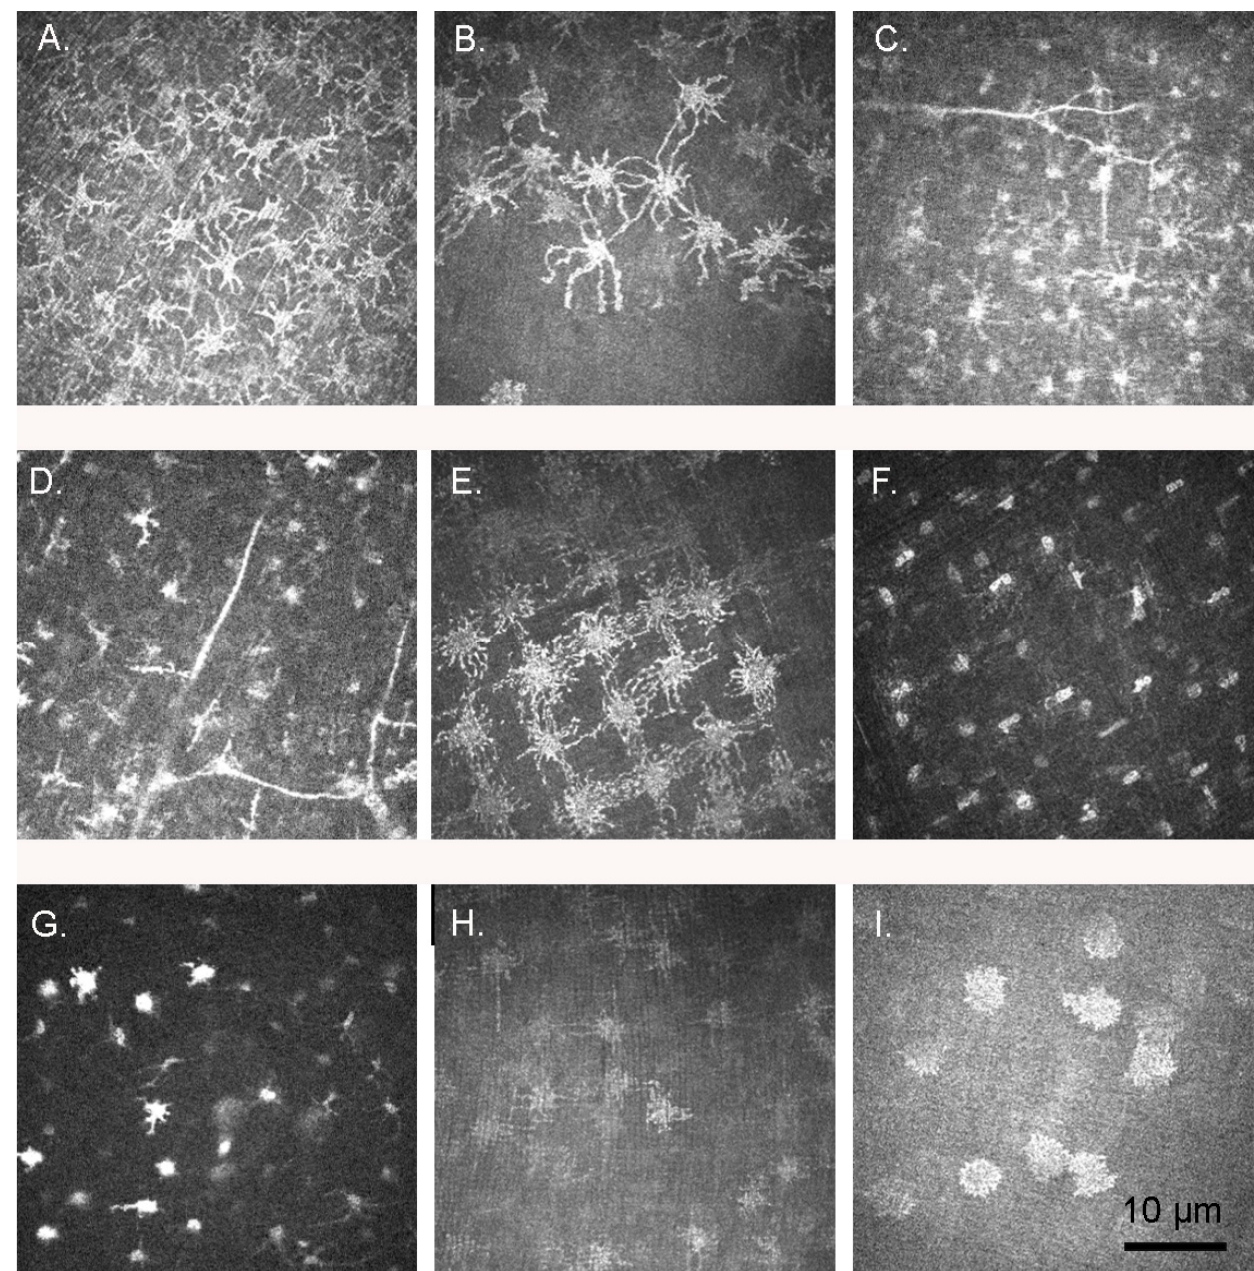
Figure 2. Stromal cells. ( A ) Anterior stroma, little penguin Eudyptula minor L2, right eye; ( B ) Anterior stroma, king penguin Aptenodytes patagonicus K4, left eye, with clear variation in cell density. In both ( A , B ) extensive processes were visible from all stromal cells. These processes were hyperreflective and obscured the nucleus. ( C ) Anterior stroma, little penguin L1, right eye; ( D ). Anterior stroma, little penguin L1, right eye. Note the dichotomous branching of the nerves in ( C , D ), which also appeared to touch some of the stromal cells. In ( D ), the branches left at an angle of approximately 90 ◦ while in ( C ) the branching angles were more acute; ( E ) Mid stroma, king penguin K3, left eye; ( F ) Mid stroma, king penguin K3, left eye. A lattice like-arrangement of keratocytes was discernible. However, the stromal cells here lacked the extensive processes visible in ( E ); ( G ) Mid stroma, little penguin L1 Similarly thin processes extended from some but not all cells and were shorter than those in ( A ) thru ( E ); ( H ) Posterior stroma, little penguin L2, right eye, again with a lattice-like arrangement of cell bodies and, in this case, processes; ( I ) Posterior stroma, gentoo penguin Pygoscelis papua G2, right eye. The processes were shorter and thicker in this section than in some other sections of the same and other